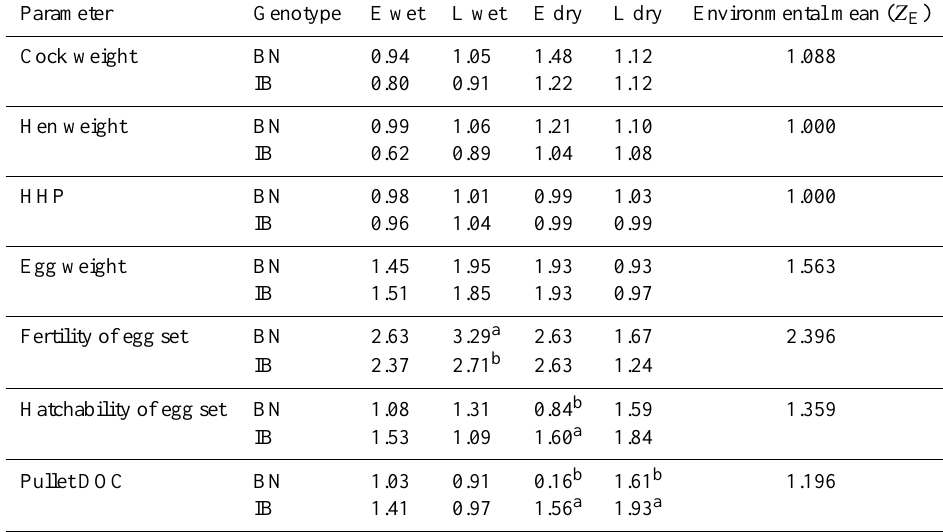
Table 4. Between-season environmentally corrected sensitivity indices for Bovan Nera and ISA Brown genotypes classified by traits. Parameter Genotype E wet L wet